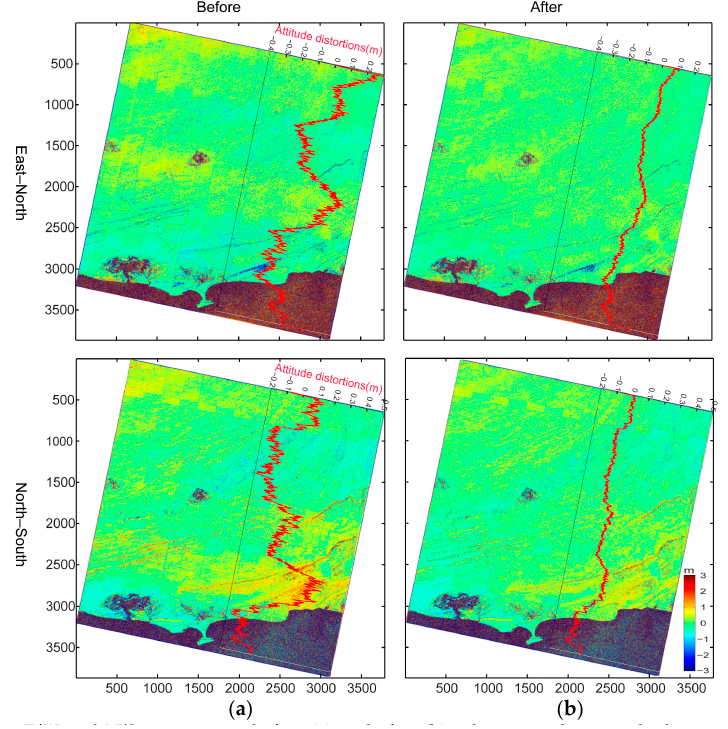
Figure 8. E/W and N/S components before ( a ) and after ( b ) subtracting the attitude distortions (red line) along the across-track direction in correlation image pair 16 November 2014–2 December 2014.